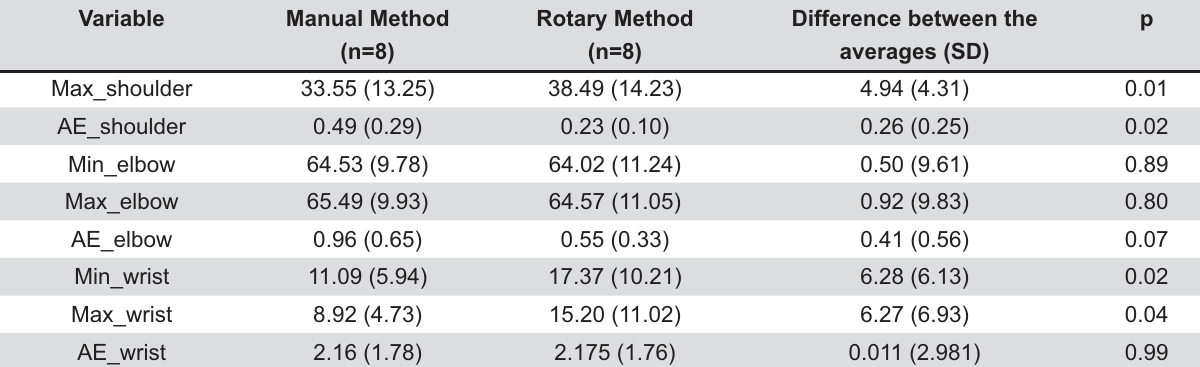
Table 1- Distribution of the sample based on maximum (max), minimum (min) angular displacement and angular excursion (AE) between the articulations over all repetitions across all subjects regarding the direction of joint movement. Average (external angle), and radial/ulnar deviation for